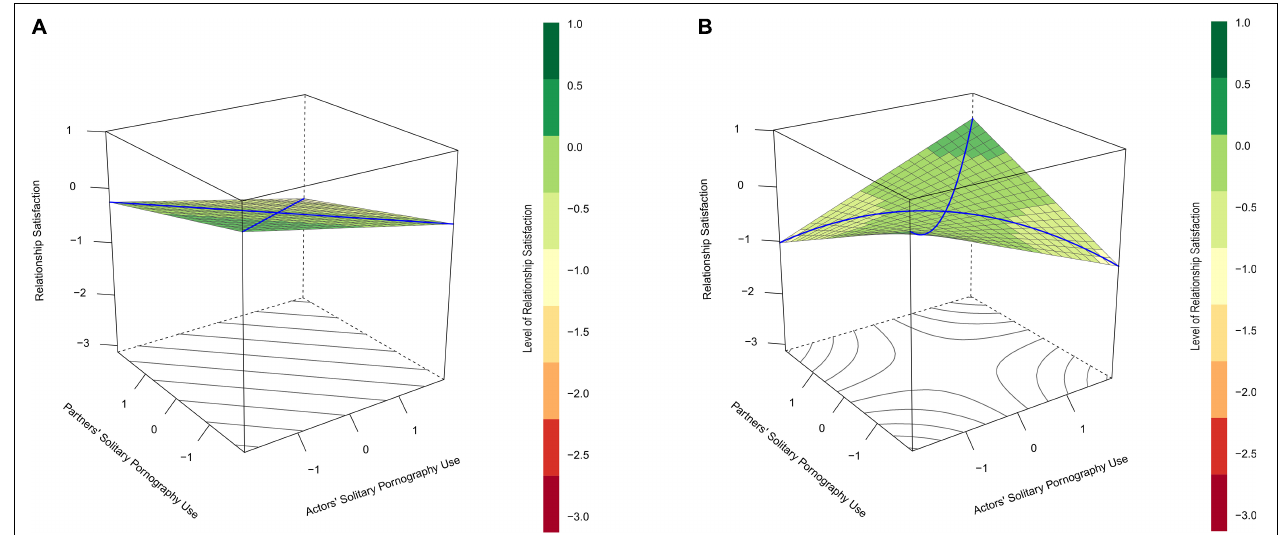
FIGURE 1 | (A) Depicts the prediction of relationship satisfaction (vertical axis) with actors’ and partners’ solitary pornography use (horizontal axes) without an interaction between these components. In this case, the plot indicates that as both actors’ and partners’ solitary pornography use increase (the back left-most corner of the plot), participants’ relationship satisfaction decreases. Note that the line of incongruence (the blue line running from left to right of this plot) is a straight line when no interaction is present in the data. The lack of curve in this line indicates the absence of similarity-dissimilarity effect in the data. In contrast, (B) depicts the hypothesized similarity-dissimilarity effect by illustrating the prediction of relationship satisfaction with an interaction between actors’ and partners’ solitary pornography use. Unlike the illustration in (A) , this plot indicates that participants’ relationship satisfaction decreases as their own solitary pornography use (i.e., actors’ solitary pornography use) increases, but only when their partners’ solitary pornography use is low. Furthermore, the line of incongruence in this example is curved rather than straight, which indicates that a similarity-dissimilarity effect is present in the data. With respect to this line, relationship quality is lower at both extreme ends, when one partner uses pornography alone very frequently and the other does not, than at the midpoint, when both partners use pornography alone at a modest